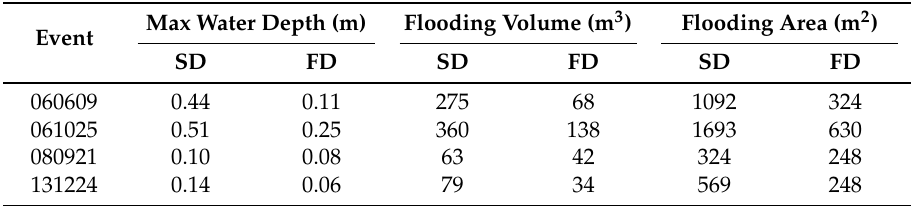
Table 3. Summary of modeling results on Praça 8 de Maio, Zona Central case study.